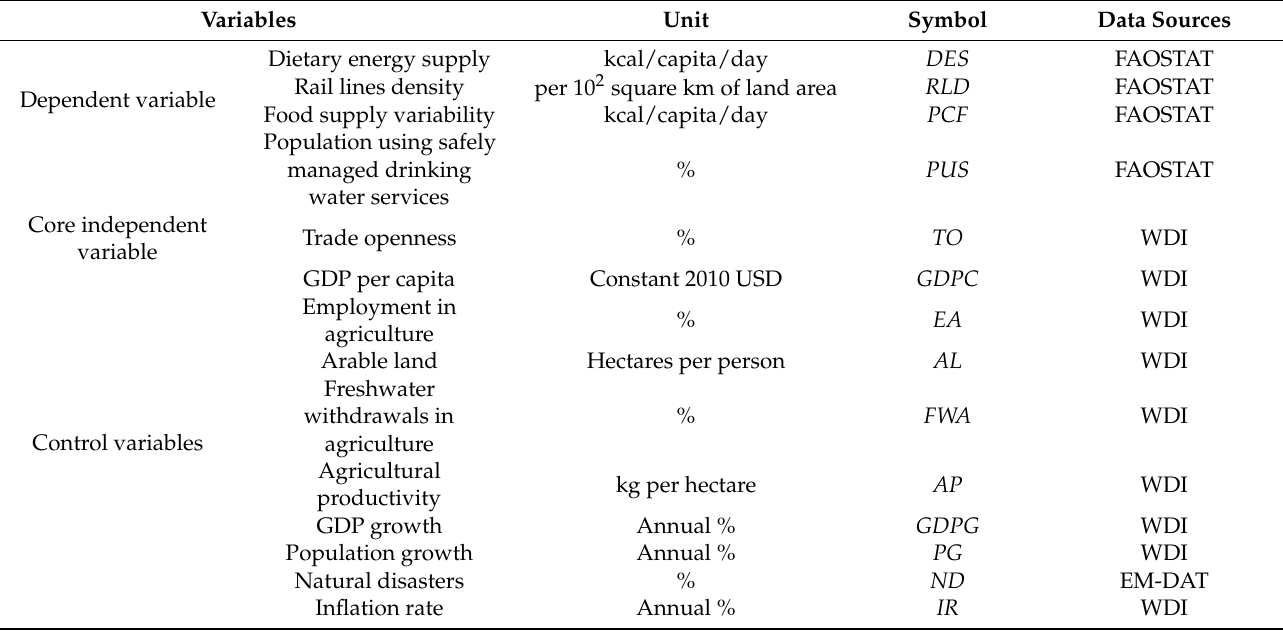
Table 1. Variables and their data